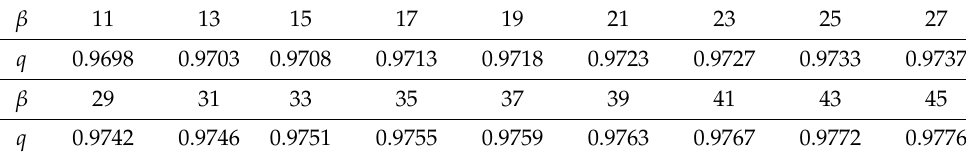
Table 1. The estimated GS slope q of BKZ β -reduced lattice